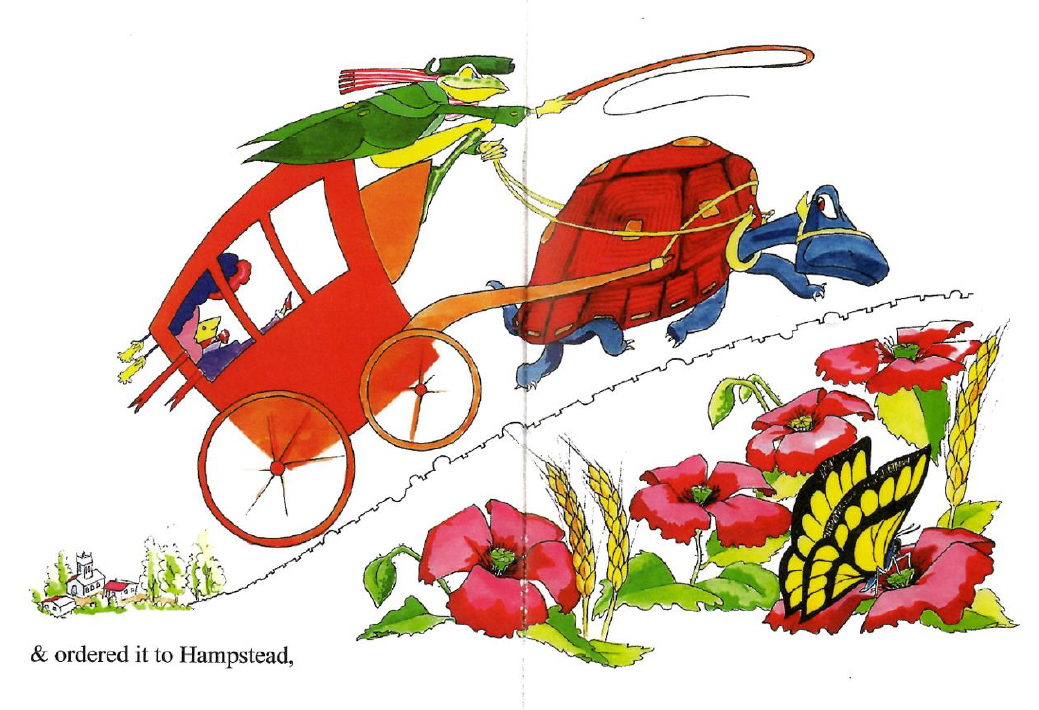
Figure 8. McMaster’s illustration for The Beautifull Cassandra (Austen 2021), pp.